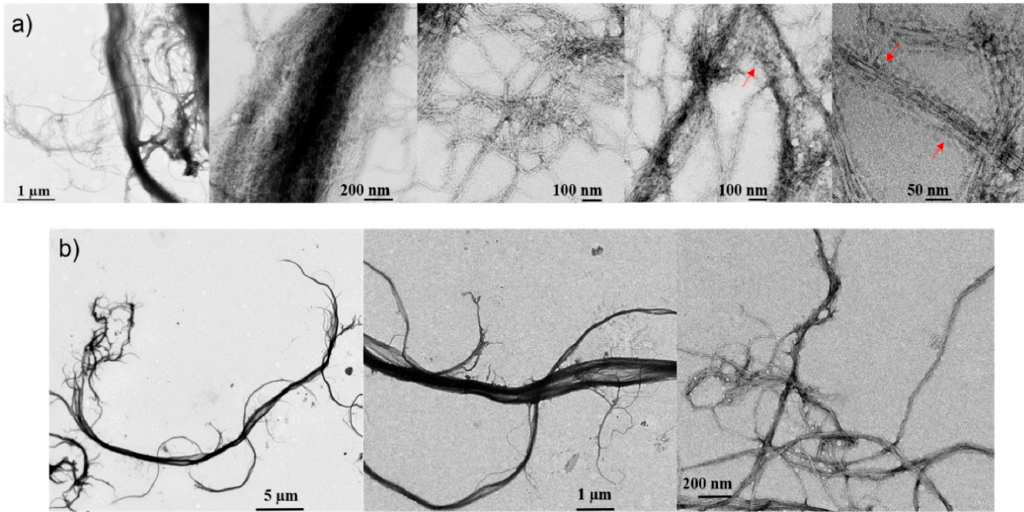
Figure 1. Transmission electron micrographs showing the size and morphology of nanofibrils within ( a ) LCNF and ( b ) CNF at different microscopic scales.